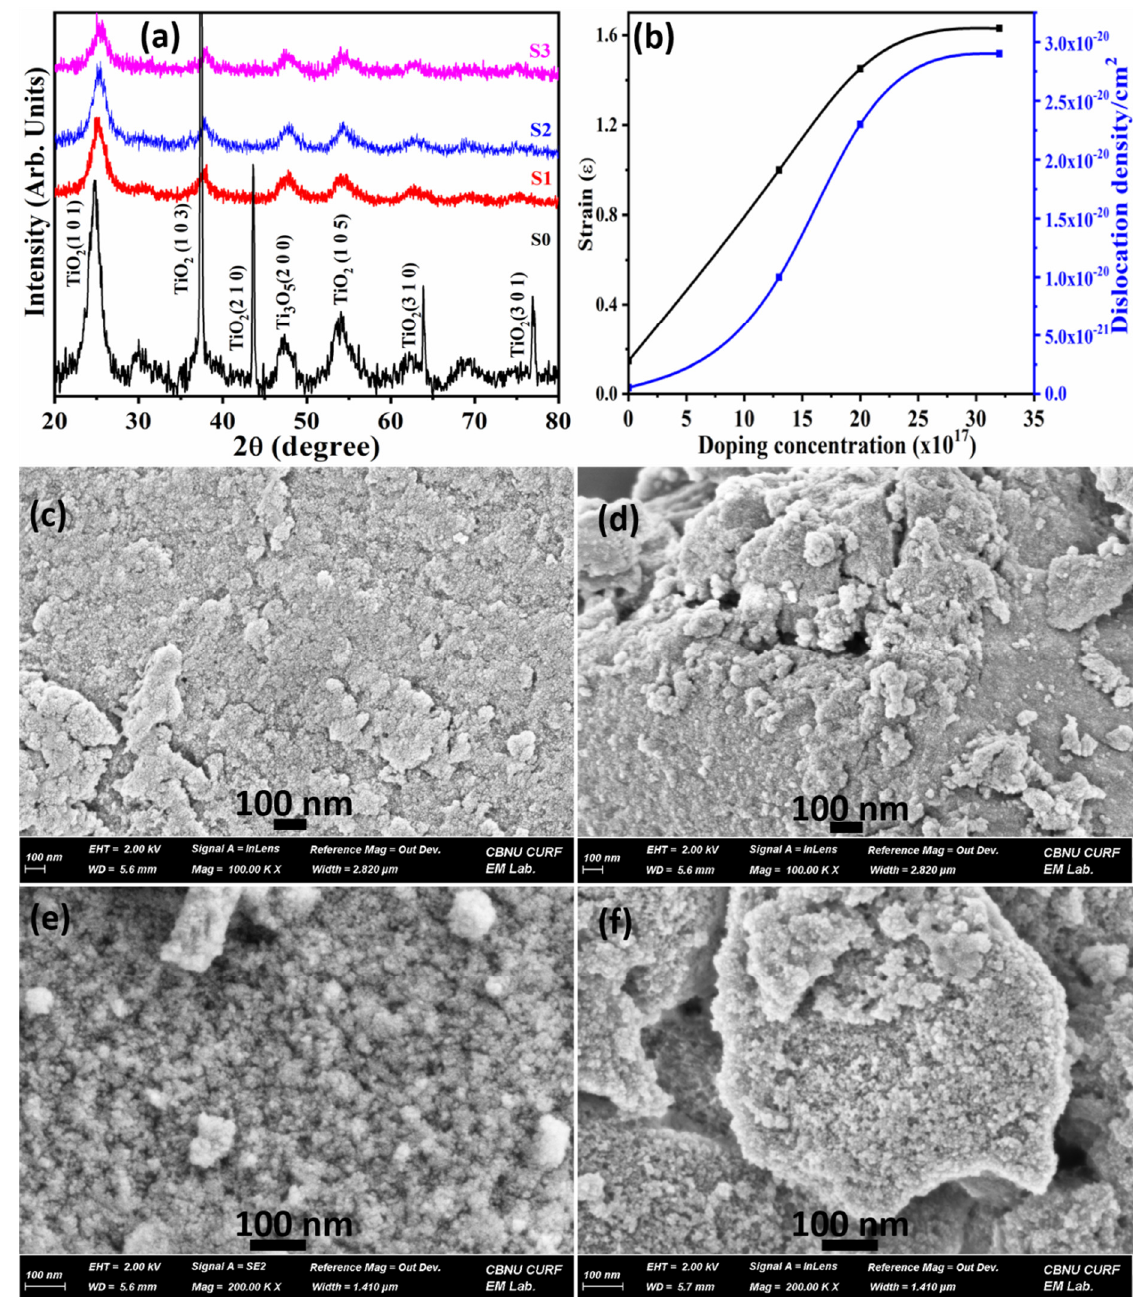
Figure 2. Typical ( a ) X-ray diffraction pattern (XRD), ( b ) Estimation of crystal strain and dislocation density and FESEM micrographs for ( c ) pristine TiO 2 ( d ) TiO 2 –Mn (13 × 10 17 atoms/cm 3 ) ( e ) TiO 2 –Mn (20 × 10 17 atoms/cm 3 ), and ( f ) TiO 2 –Mn (32 × 10 17 atoms/cm 3 ) samples.